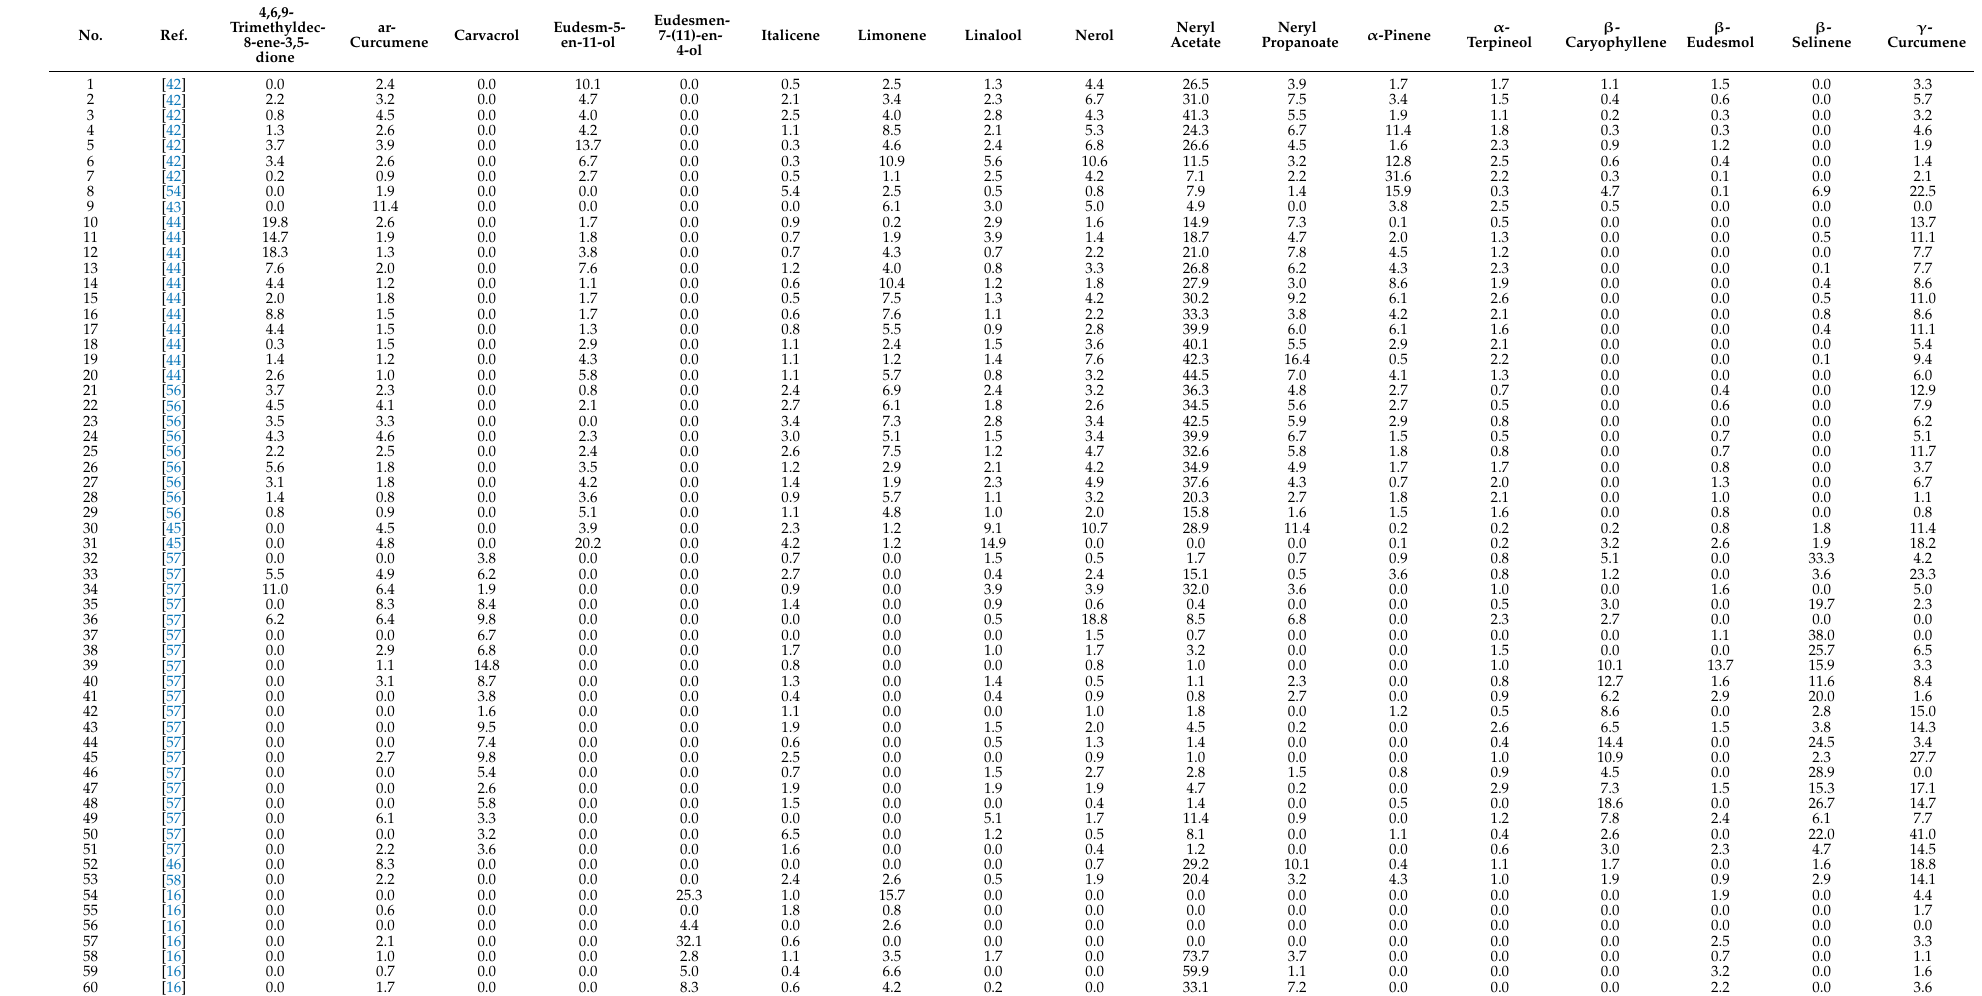
Table 5. Chemical composition of different H. italicum accessions according to